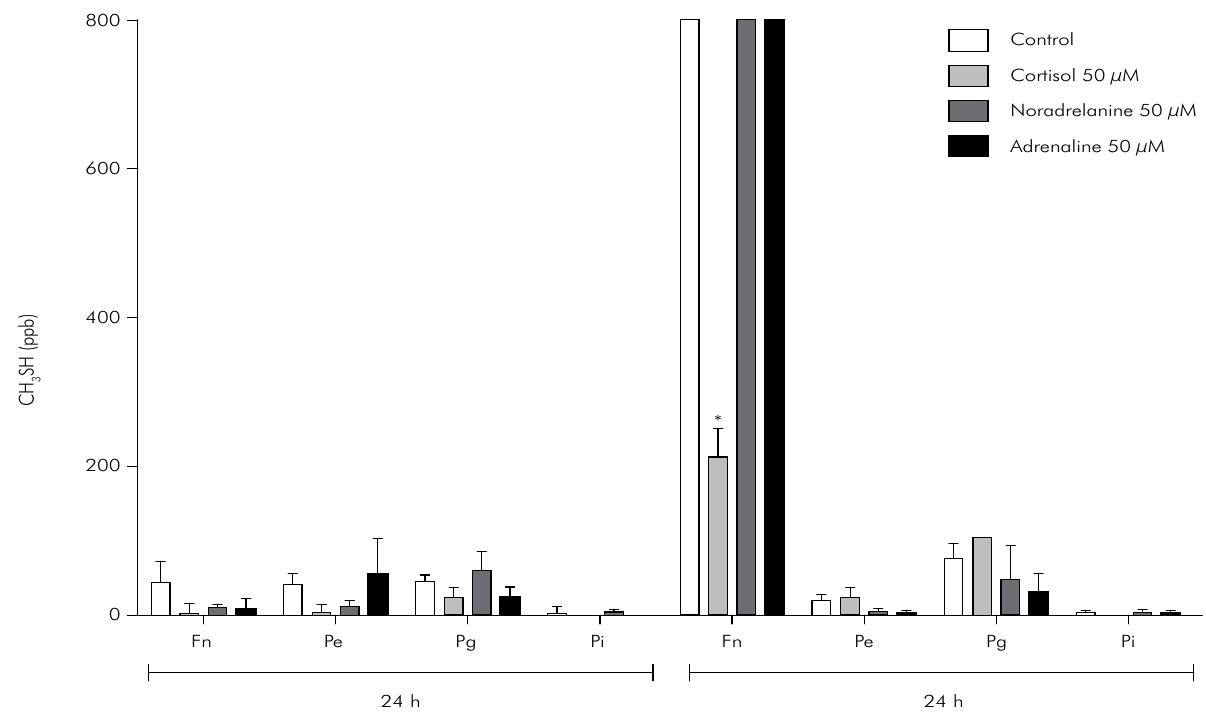
Figure 4. Median and interquartile deviation of CH SH concentrations (ppb) representing the VSCs production. Statistically signi- 3 ficant p values are shown (*) on the upper side of the columns ( p < 0.05, Kruskal Wallis,